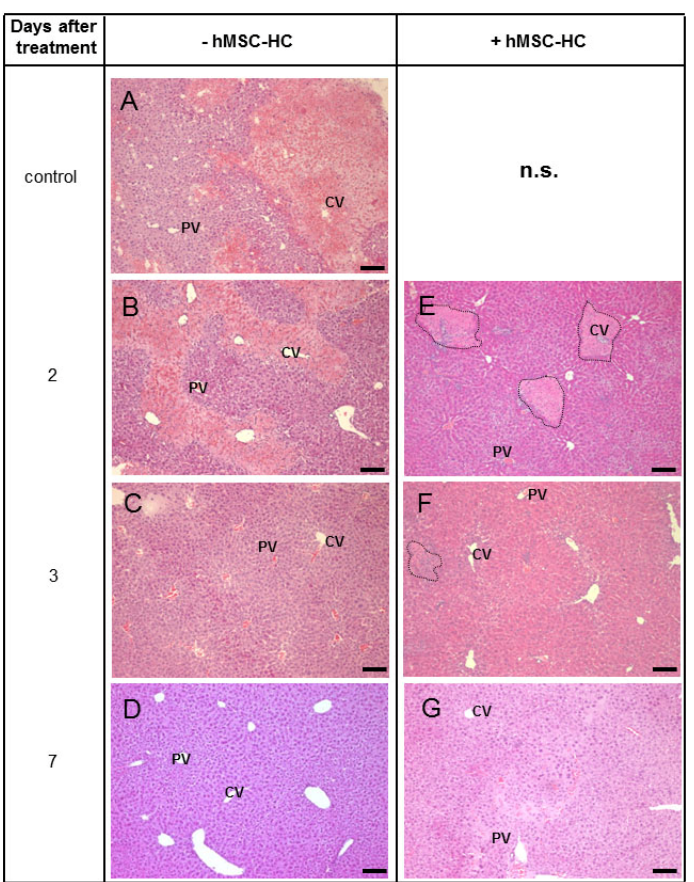
Figure 3. Time course of liver damage after treatment with APAP and